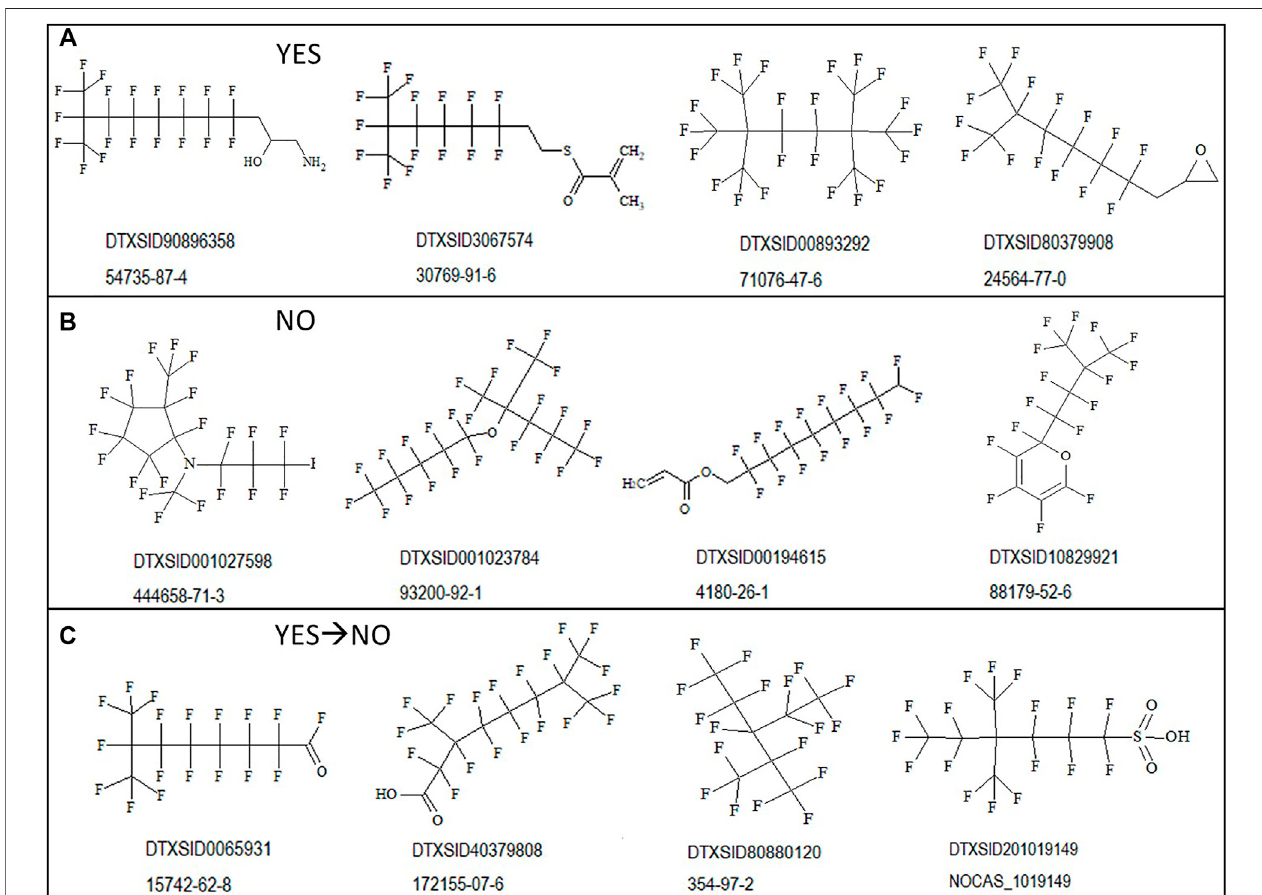
FIGURE 4 | Sample structures for possible outcomes when applying the PFOA Work fl ow shown with the associated DTXSID and CASRN: (A) structures falling withinthe SCPFOA listing (YES); (B) structures notfalling withinthe SCPFOA listing, withmolecularformula containingC8F15 (NO); and (C) structures satisfying the In- rule but whose result is negated by an Out-rule